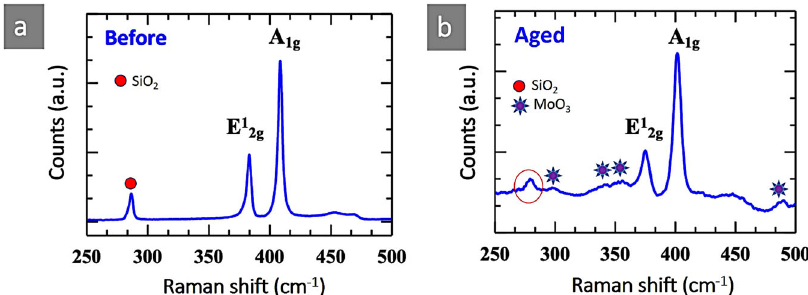
Fig. 4 Samples vibrational characterization before and after aging. a Typical Raman spectra of a grown MoS 2 sample (pristine). b Raman spectra of the long-term aged sample (36